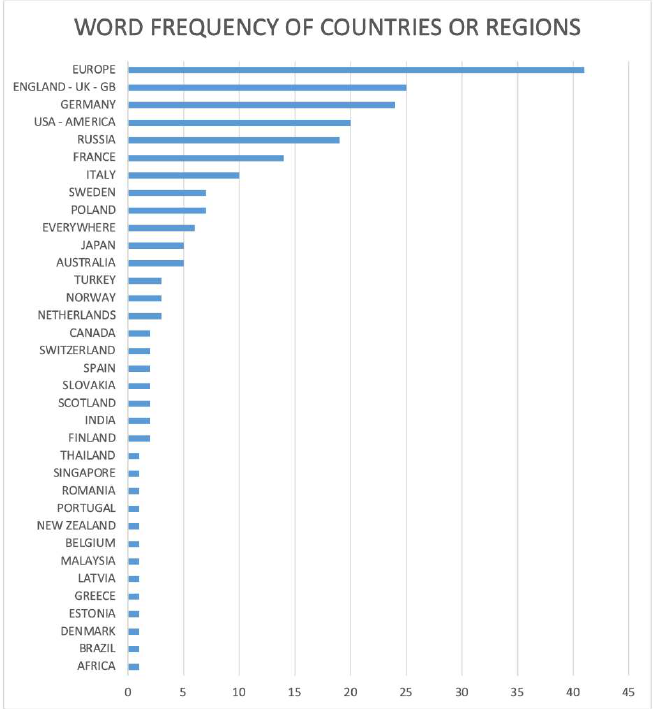
Credit: Peake and